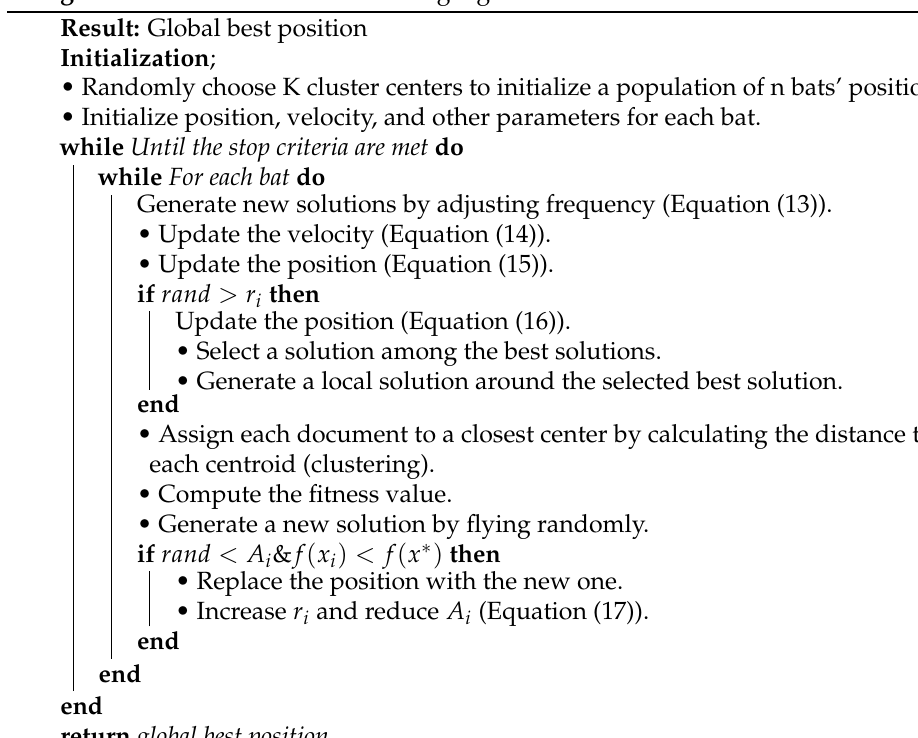
Algorithm 3: BA document clustering